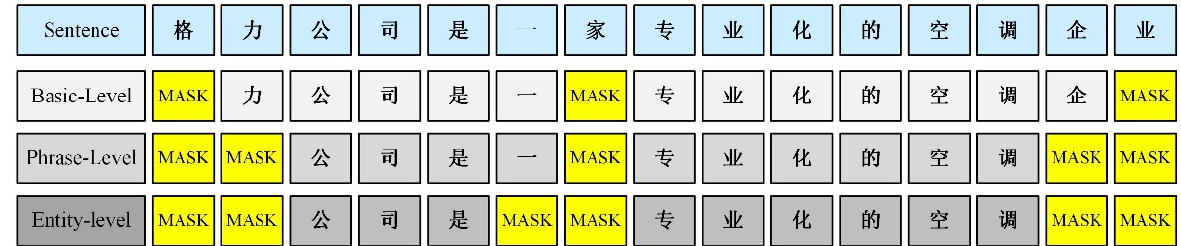
Figure 2. Comparison of BERT and ERNIE masking strategy in Chinese sentence.